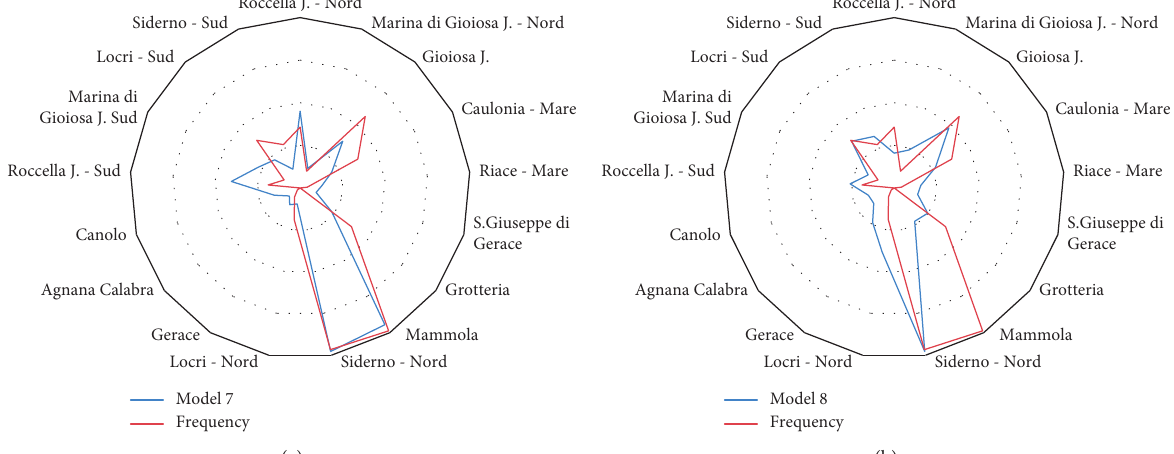
Roccella J. - Nord